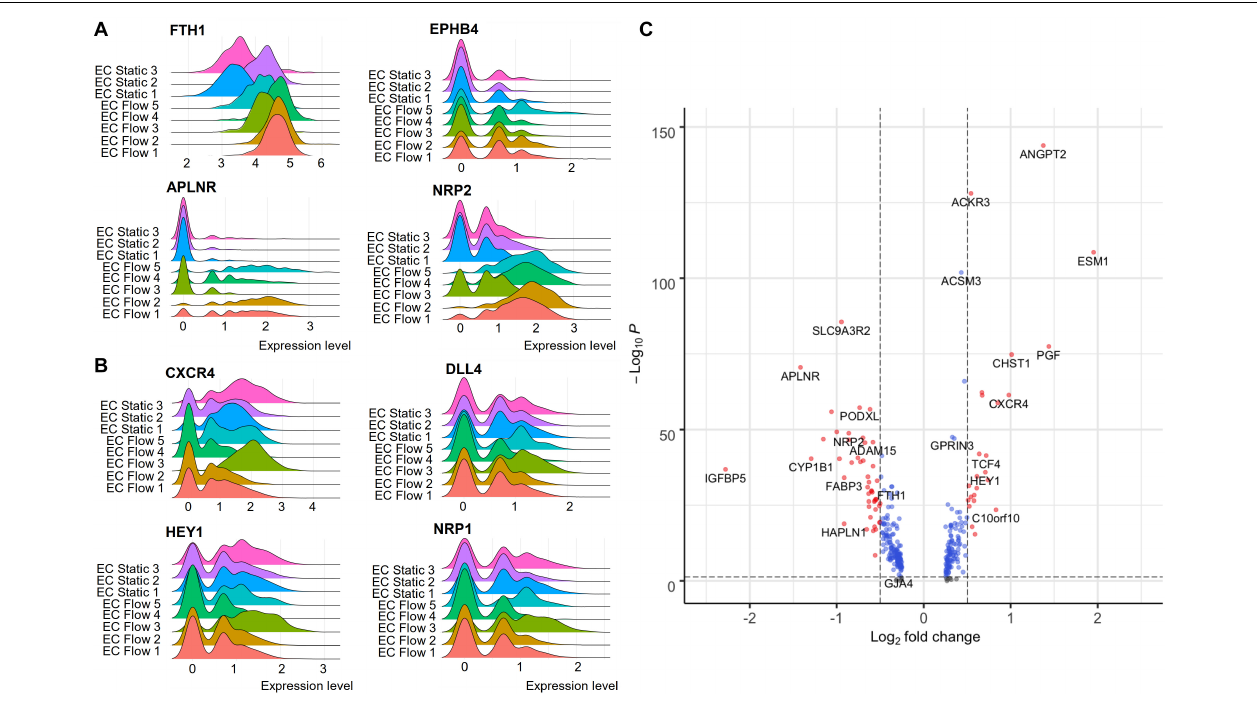
FIGURE 3 | The expression of venous and arterial genes in hiPSC-ECs flow and static clusters (HEL47.2). (A) , Venous genes. (B) , Arterial genes. (C) , Volcano plot on the differential expression of flow arterial-like cluster 3 genes compared to all the other flow clusters.